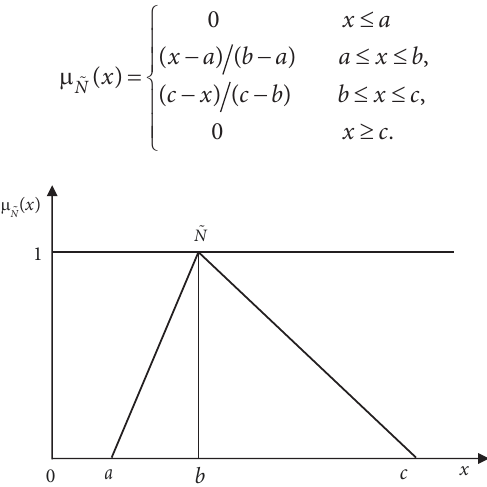
Figure 1. Triangular fuzzy number (TFN) ( , , ) N a b c =  (source: Buyukozkan, Cifci